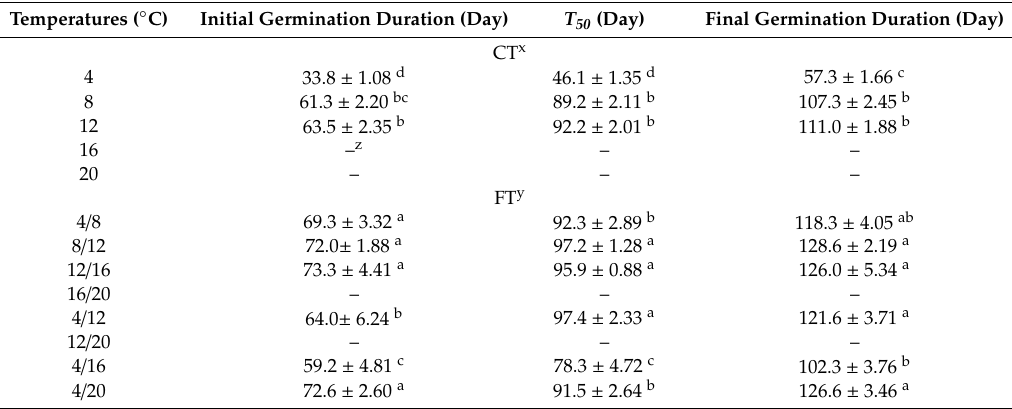
Table 1. Germination days of Tulipa thianschanica seeds at different temperatures.